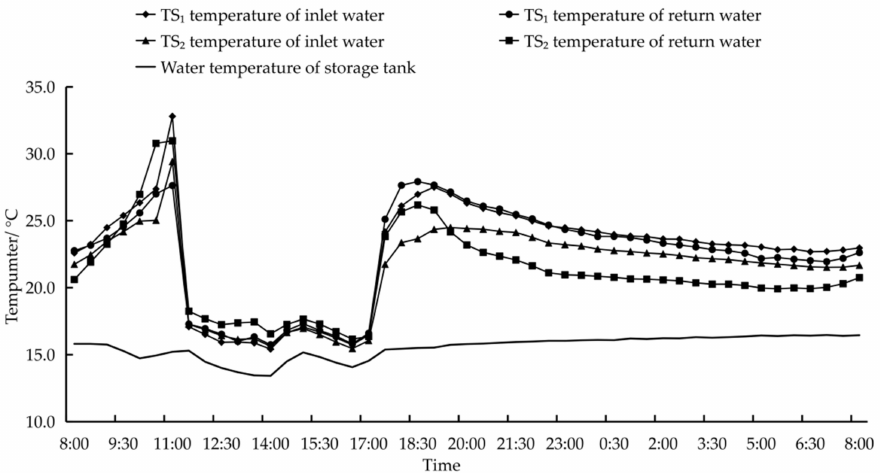
Figure 8. Temperature change in the water temperature measuring point of